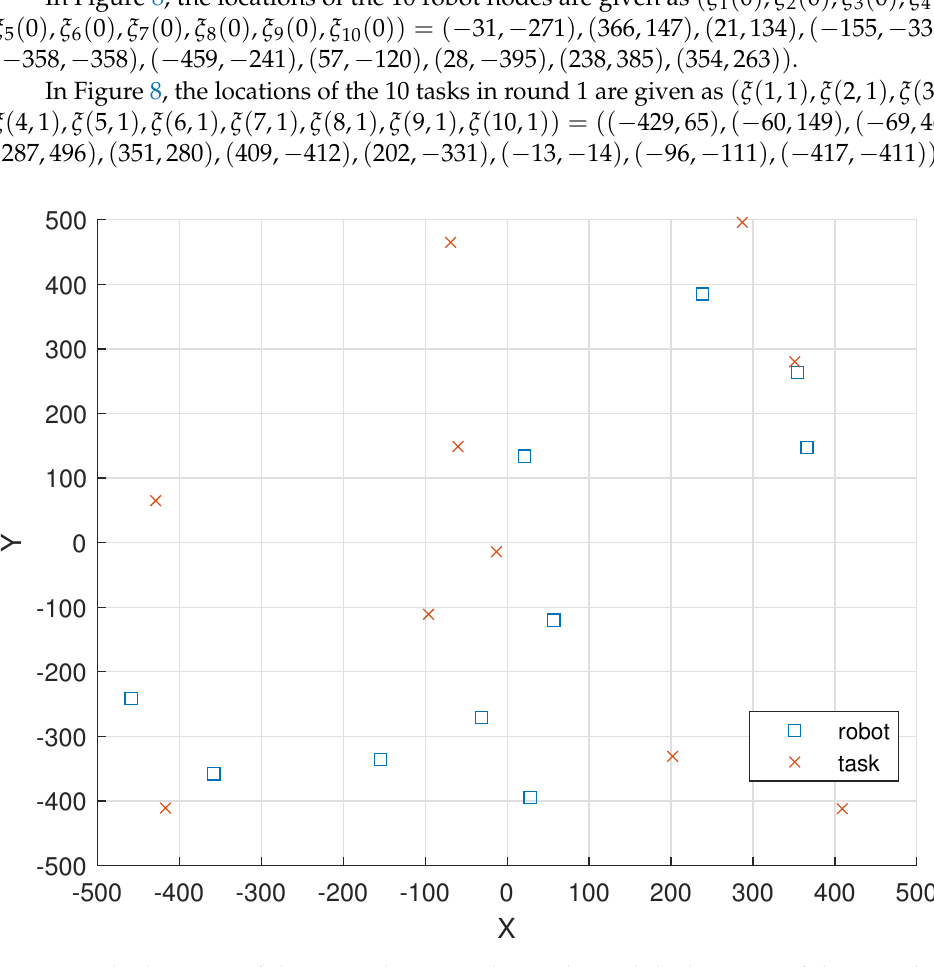
Figure 8. The locations of the 10 Markov EH robot nodes and the locations of the 10 tasks are represented as “square” and “cross” markers,